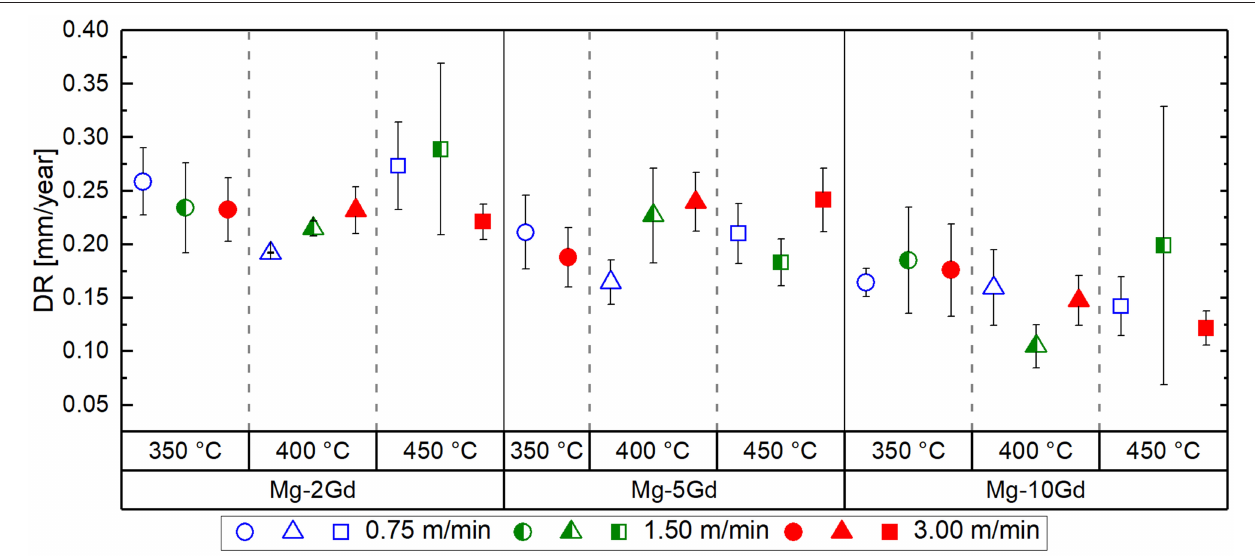
FIGURE 7 | Mean degradation rates after 7 days immersion. Error bars are standard deviations.